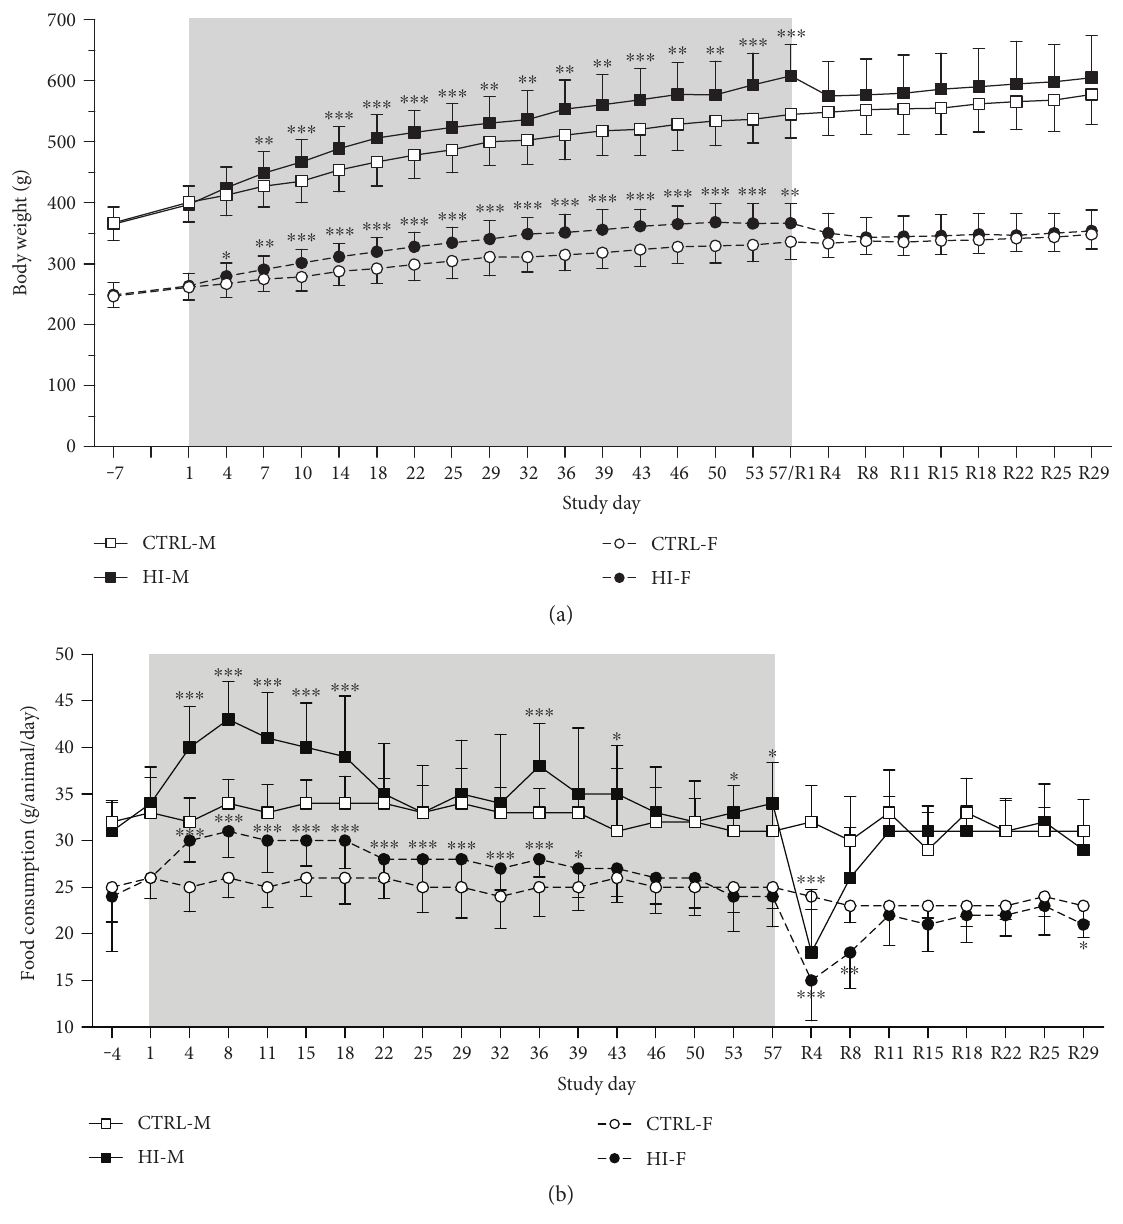
Figure 1: (a) Body weight, group mean+ SD. (b) Food consumption, group mean +SD. Grey areas indicate infusion period. Days − 7 to 29: n = 32 − 38/group per time point, days 32 – 57: n = 20 − 28/group per time point (except for days 53 and 57 for group HI-M, where n = 15 − 17/time point ), and days R4 – R29: n = 5 − 10/group per time point. ∗ p < 0 05 , ∗∗ p < 0 01 , and ∗∗∗ p < 0 001 versus